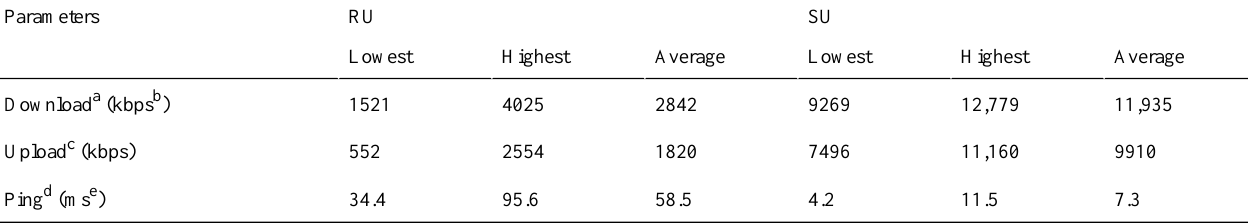
Table 7. Internet speed in the specialized unit and the remote unit measured on September 18, 2012. SURUParameters AverageHighestLowestAverageHighestLowest 11,93512,7799269284240251521Download a (kbps b ) 991011,160749618202554552Upload c (kbps) 7.311.54.258.595.634.4Ping d (ms e